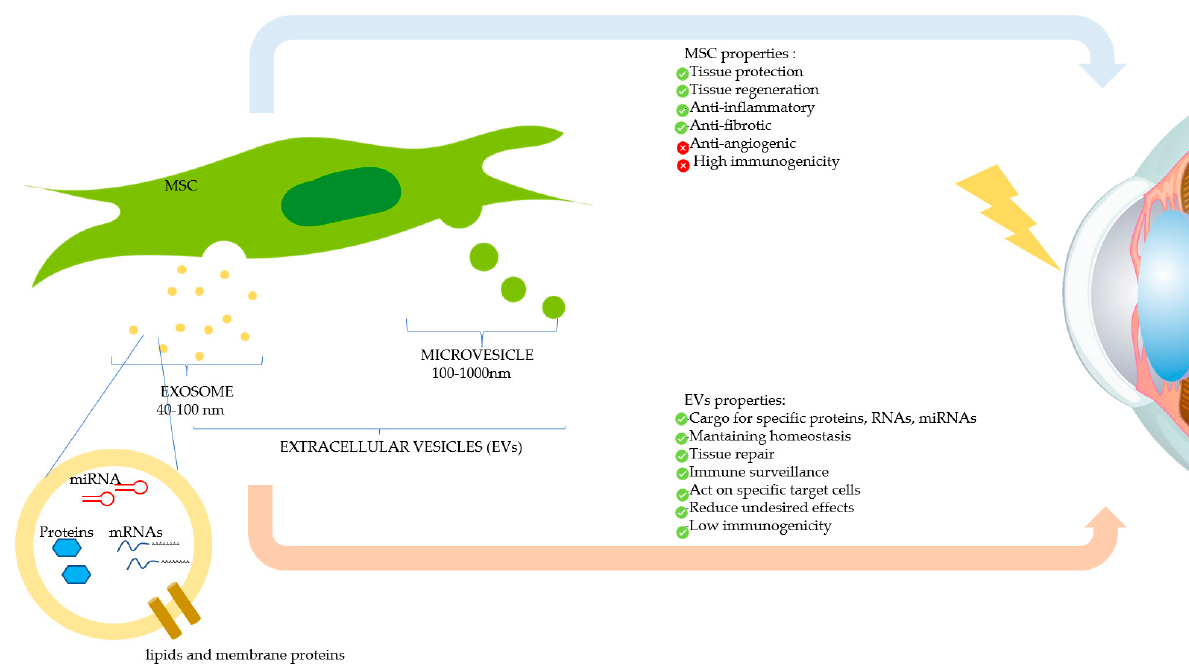
Figure 4. Therapeutic effects of mesenchymal stromal/stem cells (MSCs) and MSC-derived extracellular vesicles (EVs) on the damaged cornea. MSCs can modulate corneal repair through its paracrine action, by secreting soluble factors, or by releasing EVs, which contain therapeutic biomolecules. The two main types of EVs (exosomes and microvesicles) are shown. Table 2. Current clinical trials employing EVs in ocular diseases [53]; MSC: Mesenchymal stem cells; cGVHD: corneal Graft versus Host Disease.